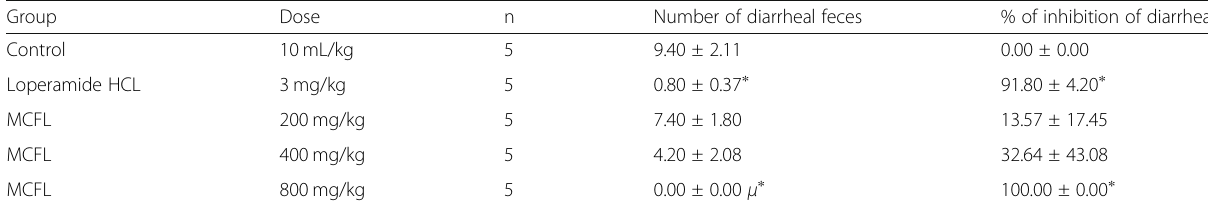
Table 2 Effect of MCFL in MgSO 4 induced diarrheal test Group Dose